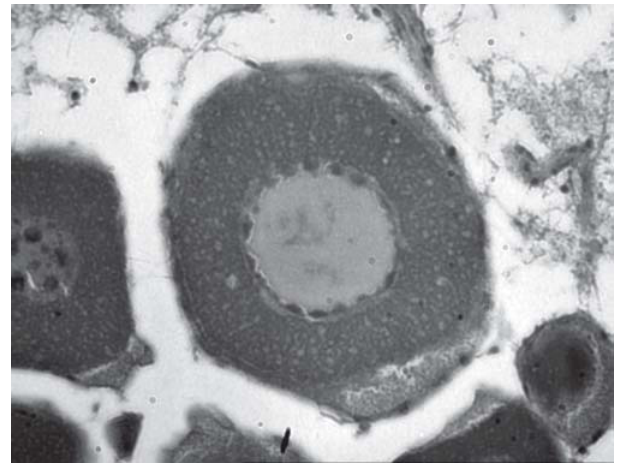
Fig. 3. Merluccius hubbsi: oocyte in perinucleolar stage (cen- ter) (0.16mm length field).